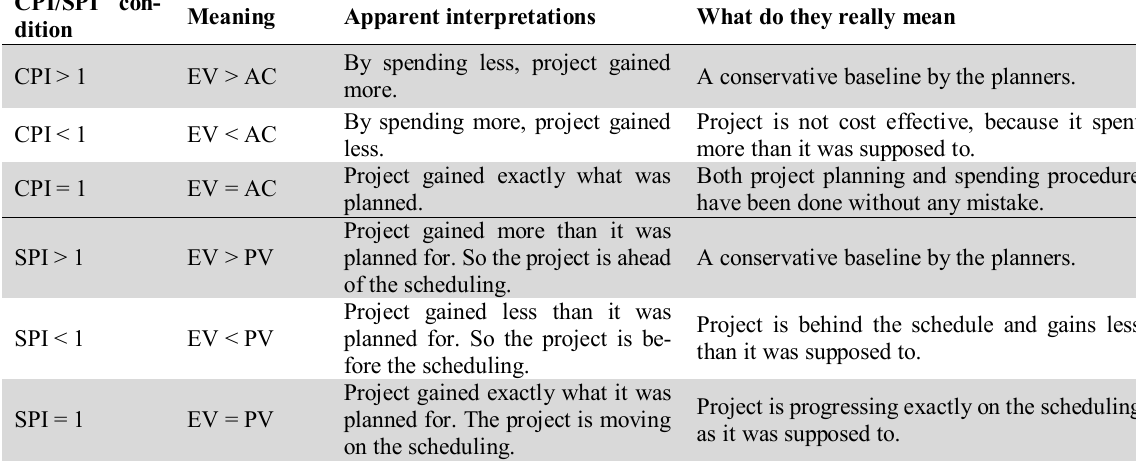
Interpretation of the performance